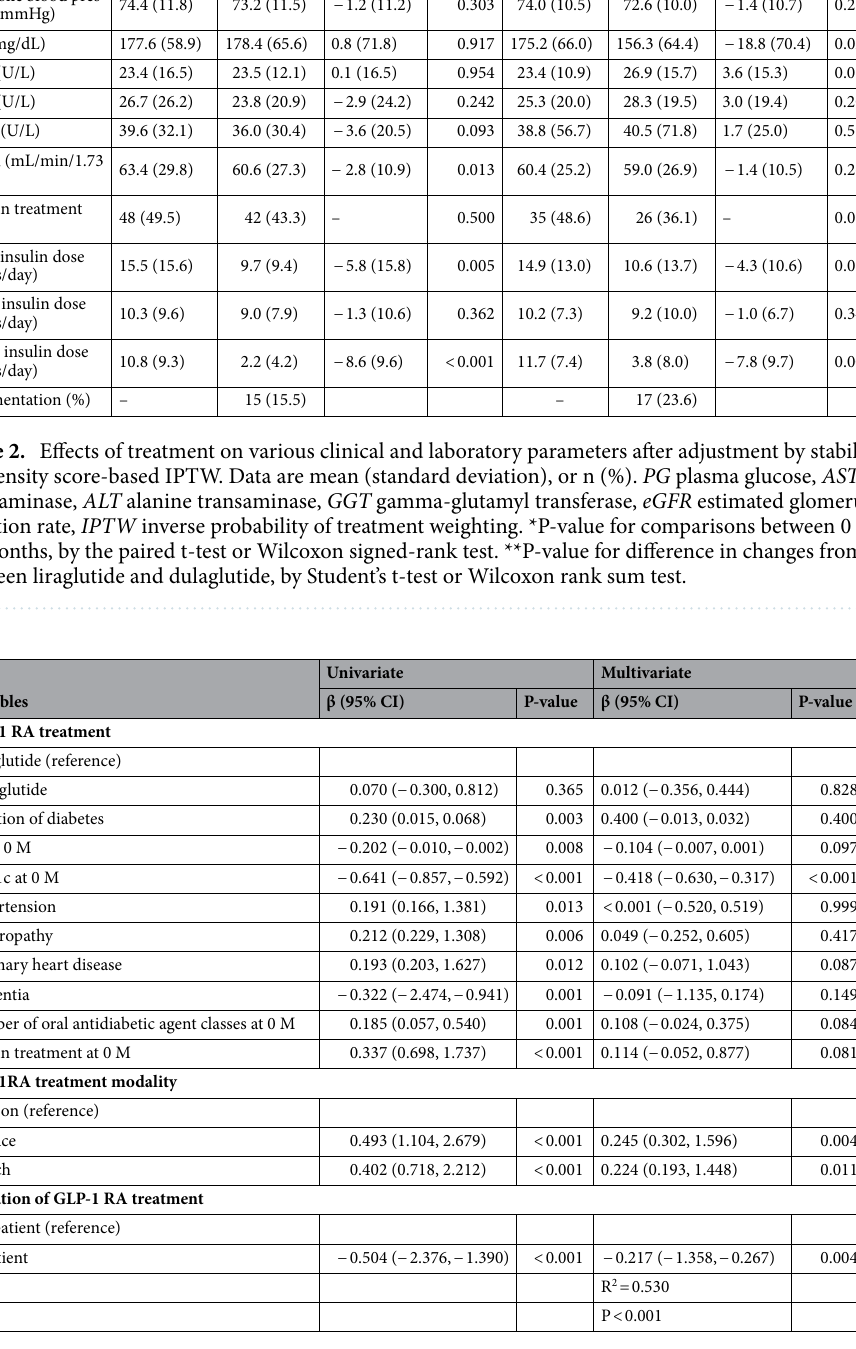
Table 3. Multivariate linear regression analysis with changes in HbA1c at 12 months as the dependent variable in patients with type 2 diabetes mellitus after adjustment by stabilized propensity score-based IPTW. PG plasma glucose, HbA1c glycated hemoglobin, GLP-1 RA glucagon-like peptide-1 receptor agonist, M month, IPTW inverse probability of treatment weighting. Factors with P < 0.05 on univariate linear regression analysis and GLP-1 RA treatment were entered in this multivariate linear regression